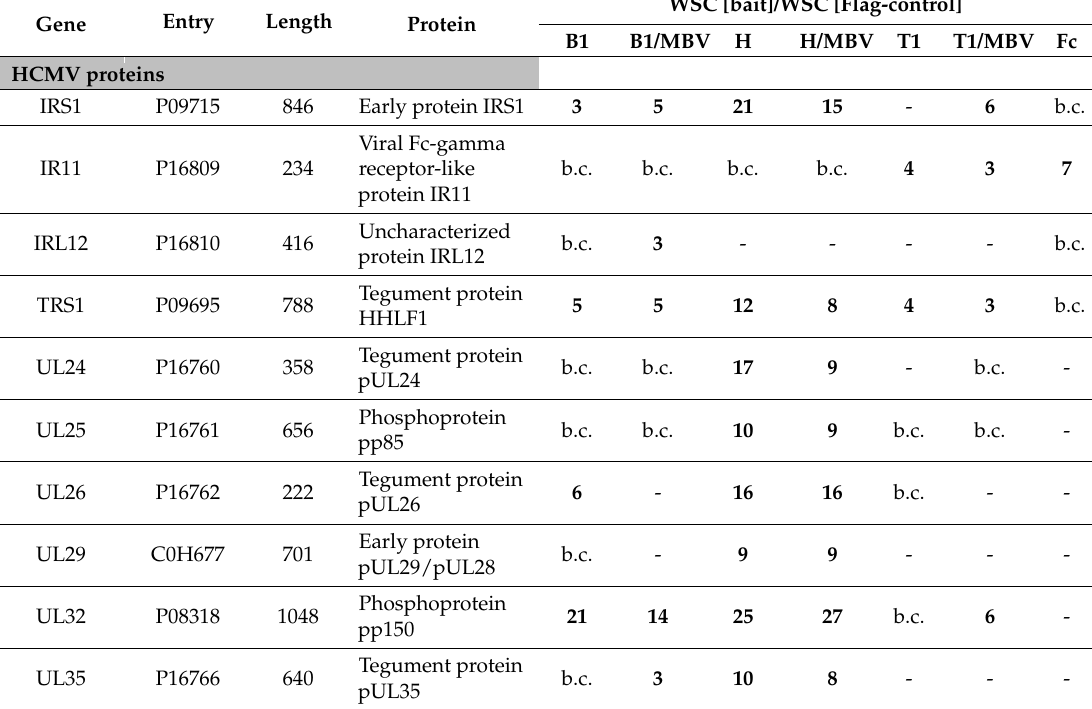
Table 4. Viral proteins and CDK/cyclin-specific proteins coimmunoprecipitated with antibodies